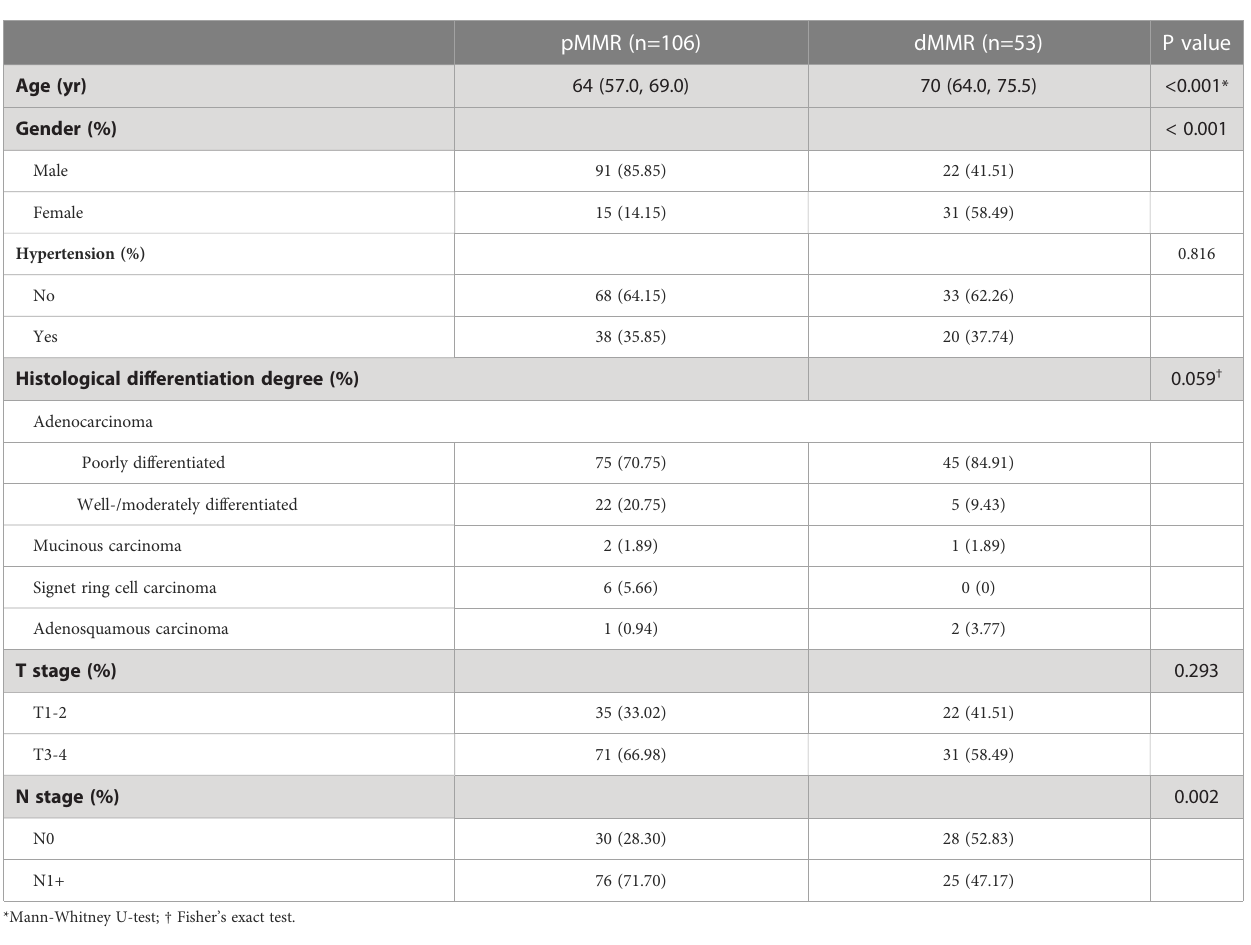
TABLE 1 Demographic and clinical characteristics of the study